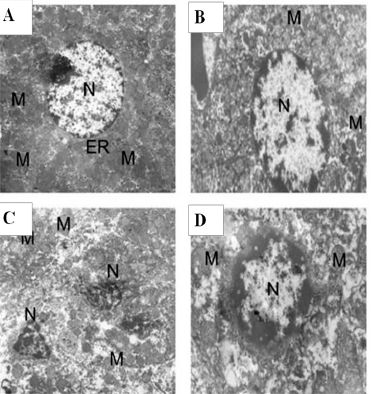
Figure 5. Ultrastructural analysis of liver tissue by transmission electron microscope (TEM). ( A ) Normal rats; ( B ) 1,3-BPMU alone; ( C ) tumor control; ( D ) DEN + 1,3-BPMU rats. Mitochondria (M), endoplasmic reticulum (ER) and nucleus (N).